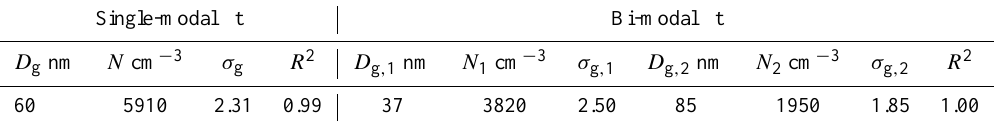
Table 2. Modal fit parameters for median size distribution of the two-year period at El Arenosillo considered single- and bi-modal fits for particle sizes greater than 20nm. D g ,i , N i and σ I represent the geometric diameter, median number concentration and geometric standard deviation, respectively. The goodness of fit function value was characterised by the correlation coefficient ( R 2 ) .